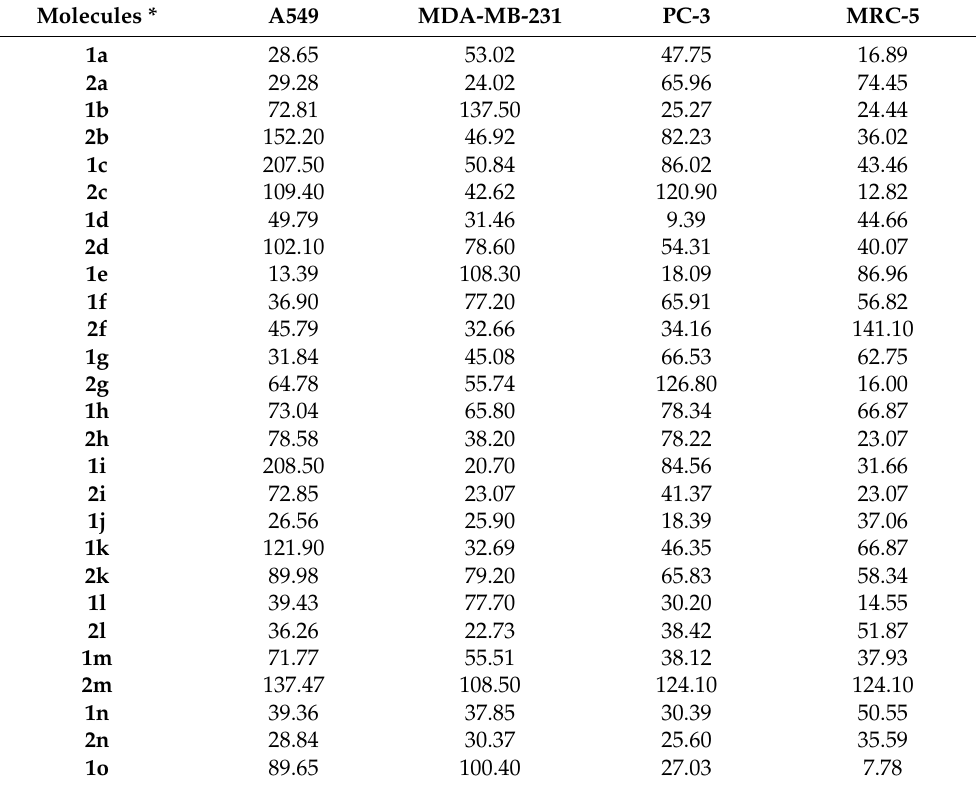
Table 1. A549, MDA-MB-231, PC-3, and MRC-5 cells were treated with N-acyl hydrazones and 2,5 substituted 1,3,4-oxadiazoles. The effect of the molecules on cell viability is expressed as IC 50 values ( µ M). Each experiment was performed in triplicate. Data are expressed as